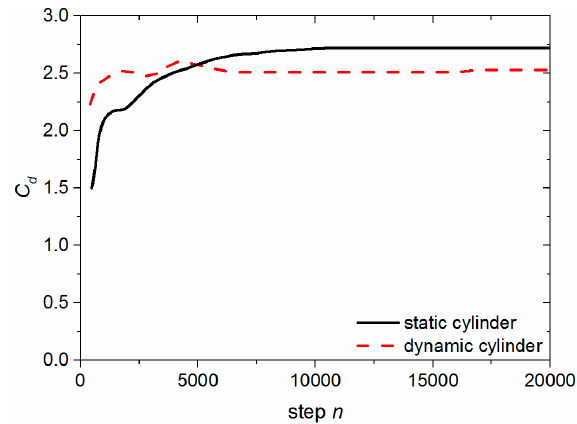
C C d . Figure 5. Comparison results of drag coefficient C d d .